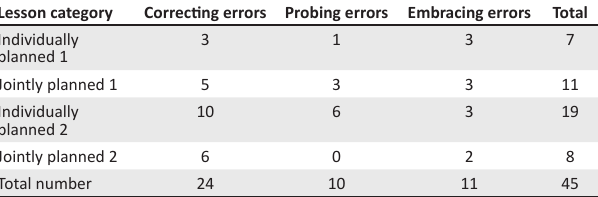
TABLE 4: The manner in which the teacher dealt with the errors. Lesson category